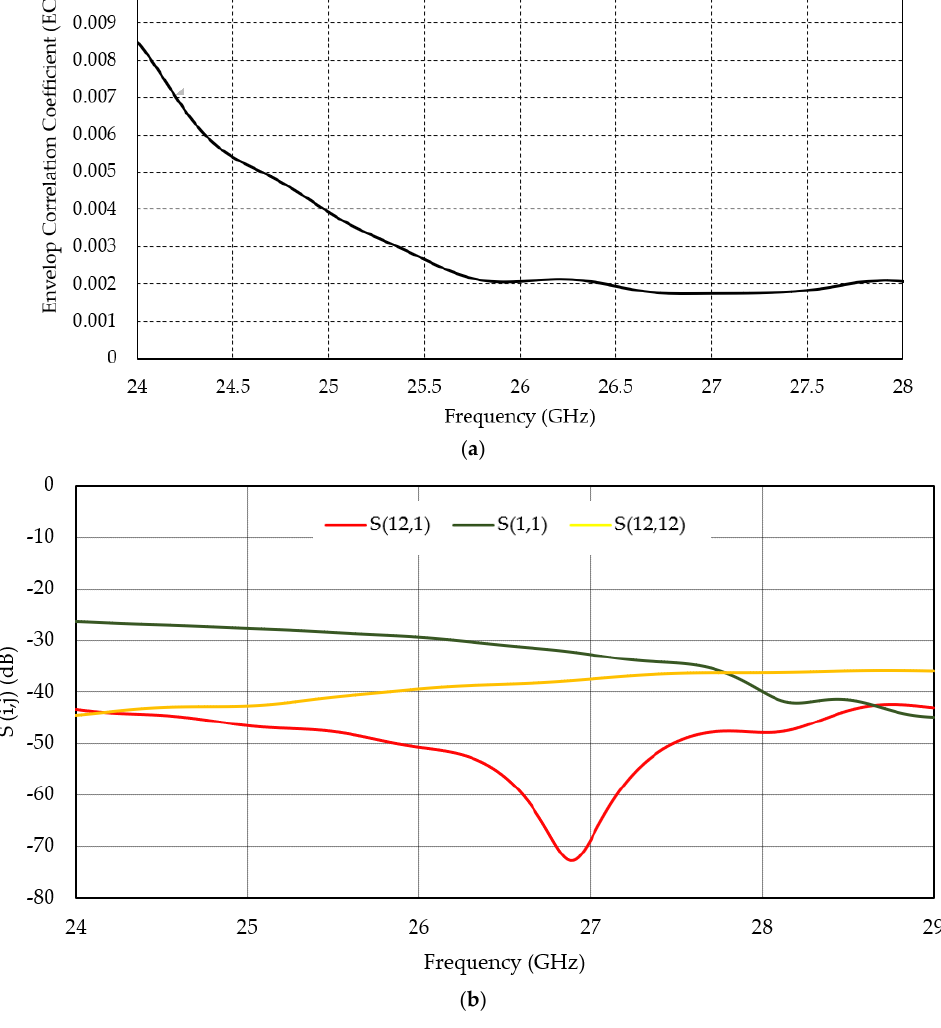
Figure 5. ( a ) Simulated correlation coefficient ( ρ ) between ports 1x and 1y (two closest ports), ( b ) S(i,j) performance of the orthogonal array.